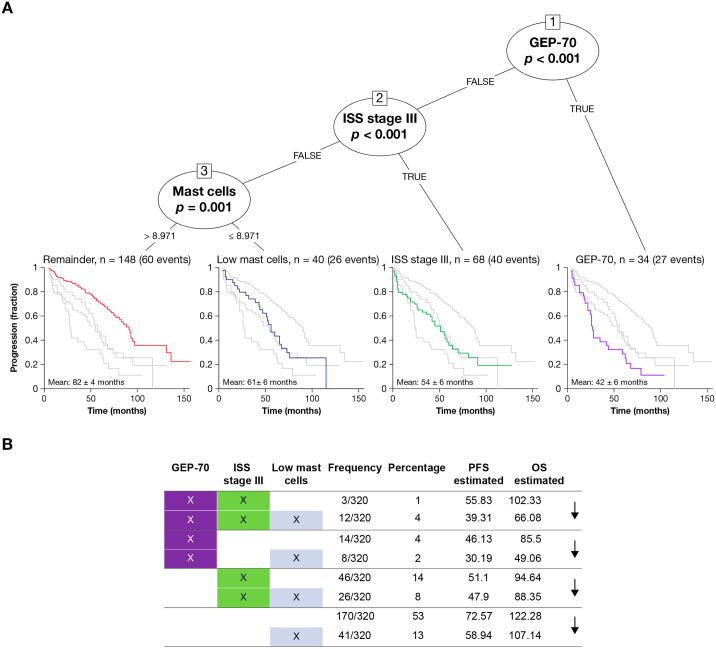
Mast cells, patient outcomes, and TME.(A) Cox proportional hazards conditional inference tree that selected an optimal combination of attributes from the cell types and clinical characteristics for the 290 pretreatment samples with known cytogenetics and tumor burden estimates. The algorithm first selects the strongest attribute (the cell-type or clinical characteristic with the lowest p-value), in this case, the GEP-70 high-risk flag (p < 0.001). As expected, those 34 patients (27 of whom had an event) with GEP-70 high-risk tumors have particularly bad outcomes (estimated mean PFS = 42 months), and no other attribute can significantly split the patient population. The algorithm then selects the attribute that best divides the remaining patient population, which is ISS stage III status (p < 0.001). These 68 patients (40 of whom had an event) without GEP-70 high-risk tumors but who are ISS stage III cannot be significantly divided by any other attribute and have relatively poor outcomes (estimated mean PFS = 54 months). The remaining 188 patients (86 of whom had an event) are best divided by deconvolution-based mast cell estimates (p = 0.001). Those 40 patients (26 of whom had an event) with predicted mast cell levels of 8.97% or lower also have relatively short PFS (estimated mean PFS = 61 months). The remaining 148 patients had a relatively long PFS of 82 months. Importantly, the model does not select any more attributes that can pass a cutoff of p = 0.01, implying that of these deconvolved immune cell estimates and clinical characteristics, GEP-70, ISS stage III, and mast cell estimates are the strongest predictors. Clinically estimated tumor burden, which is inversely correlated with deconvolved mast cell percentages, was not selected by the tree and is, therefore, less informative. (B) Pretreatment samples with known ISS stage, GEP-70 status, and mast cell signature scores (n = 320). The 8 rows show all possible combinations of GEP-70 high risk versus not high risk, ISS stage III versus not stage III, and mast cell signature as high versus low (≤ 8.97%). GEP-70, 70-gene Prognostic Risk Score; ISS, International Staging System; OS, overall survival; PFS, progression-free survival; TME, tumor microenvironment.